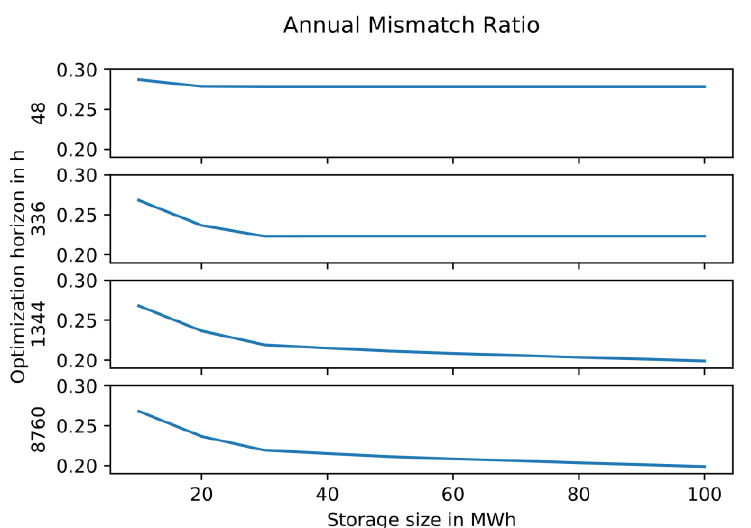
Figure 6. Annual Mismatch Ratio (AMR) for the demo district depending on the thermal storage capacity and the model capacity and the model foresight .